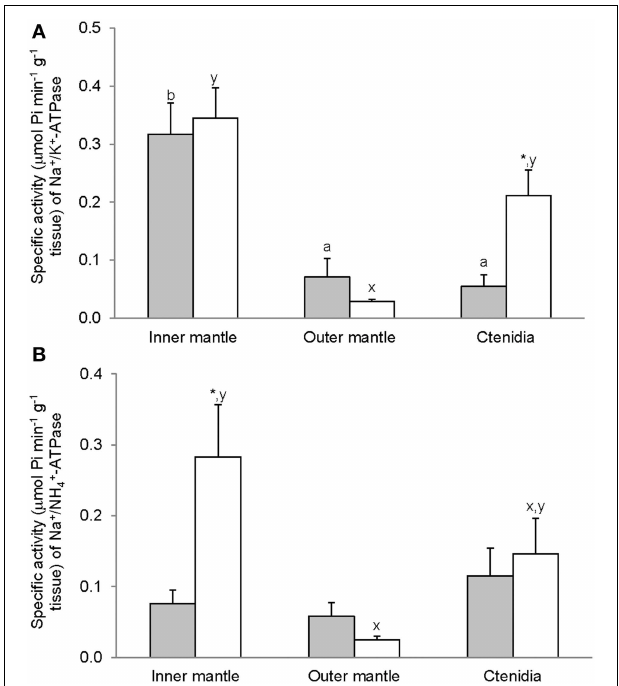
FIGURE 2 | Mass-specific activity ( µ mol Pi min − 1 g − 1 tissue) of ouabain-sensitive Na + /K + -ATPase (NKA), activated by (A) Na + /K + or (B) Na + /NH + 4 , from the inner mantle, the outer mantle and ctenidia of Tridacna squamosa exposed to 12h of darkness (control; closed bar) or 12h of light (open bar). Values represent means + S.E.M. ( N = 4 ). Means not sharing the same letter (a, b for darkness, or x, y for light) are significantly different from each other ( P < 0 . 05 ). ∗ Significantly different from the control value ( P < 0 . 05 ).